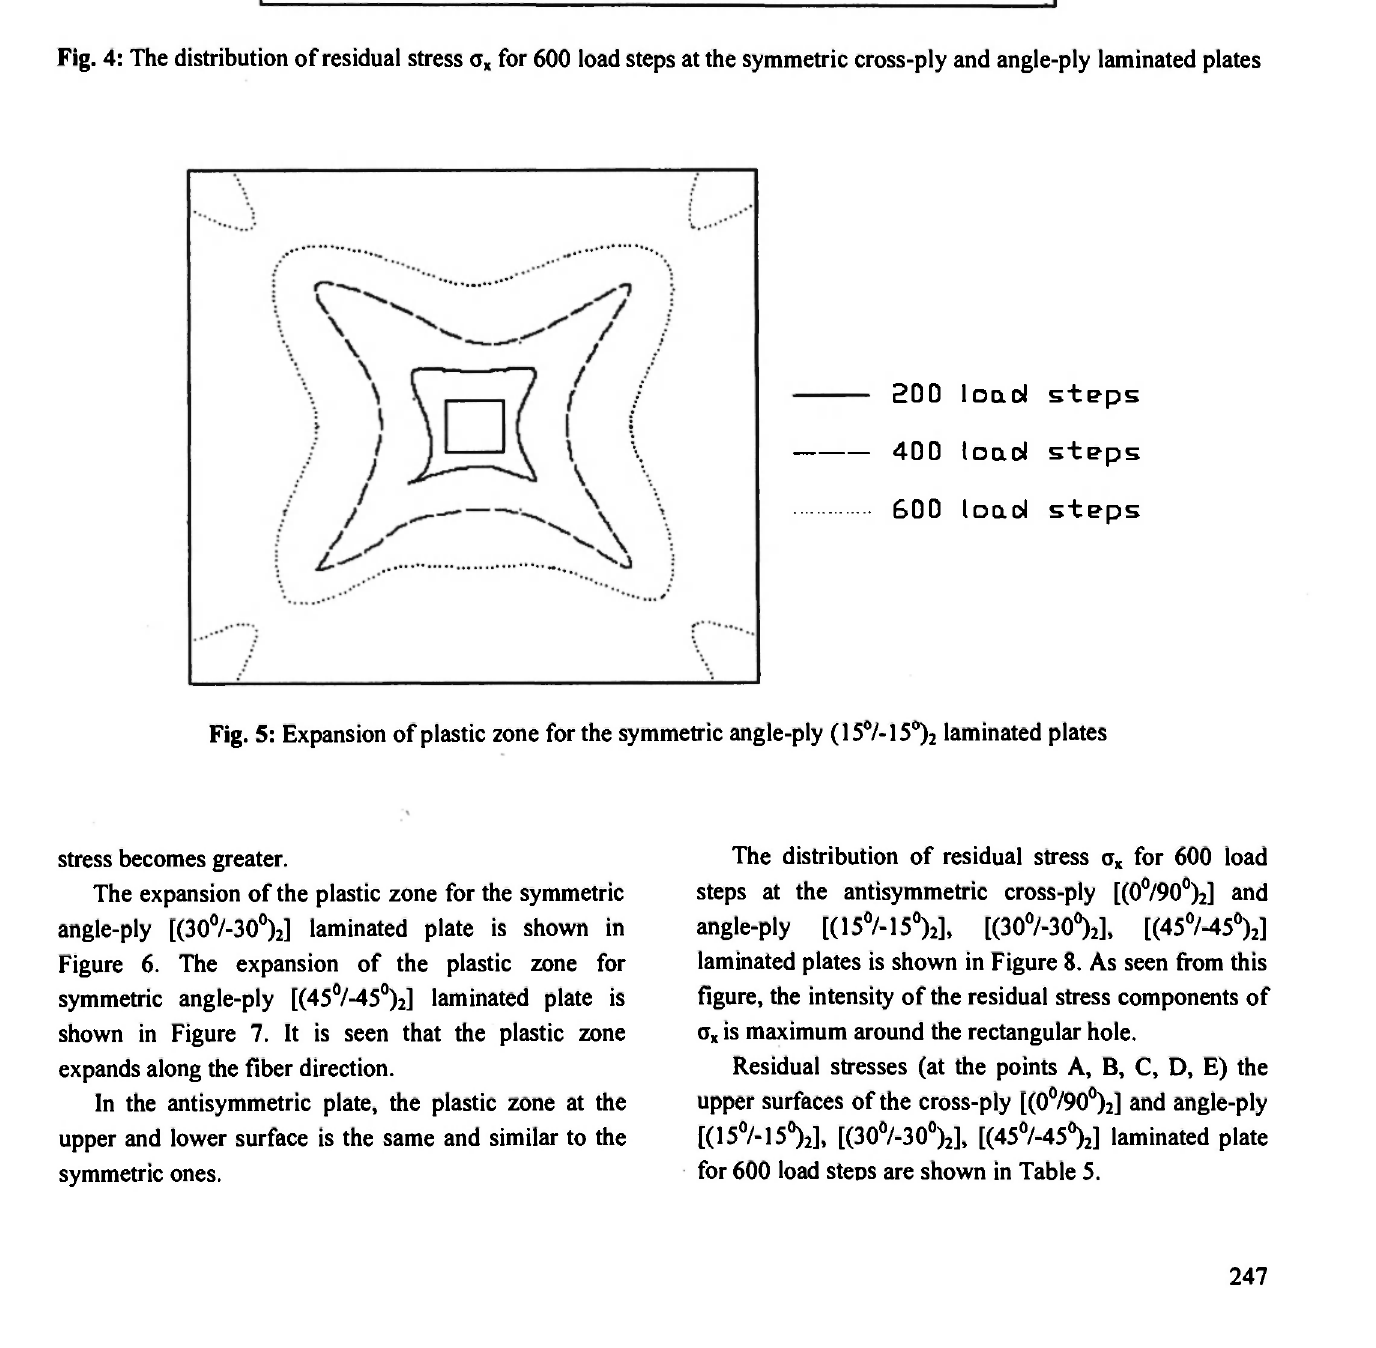
Fig. 4: The distribution of residual stress σ χ for 600 load steps at the symmetric cross-ply and angle-ply laminated plates